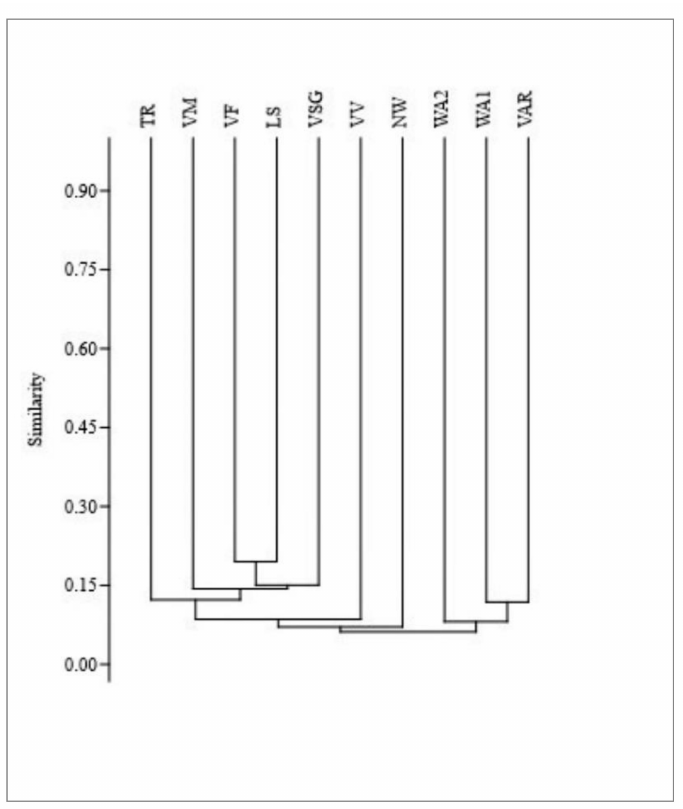
Figure 2. Cluster analysis of the medicinal plant use. Comparison among ethnobotanical works in Alpine and Prealpine regions. Traditional uses in Valmalenco (VM) and in neighboring areas. VV: Valvestino [19]; VSG: Val San Giacomo [13]; VF: Valfurva [3]; LS: Lombard Stelvio National Park [15]; WA1: Italian Western Alps [22]; WA2: Italian Western Alps [2]; NW: Italian North Western Alps [14]; VAR: Val Varaita [18]; TR: Tremezzina